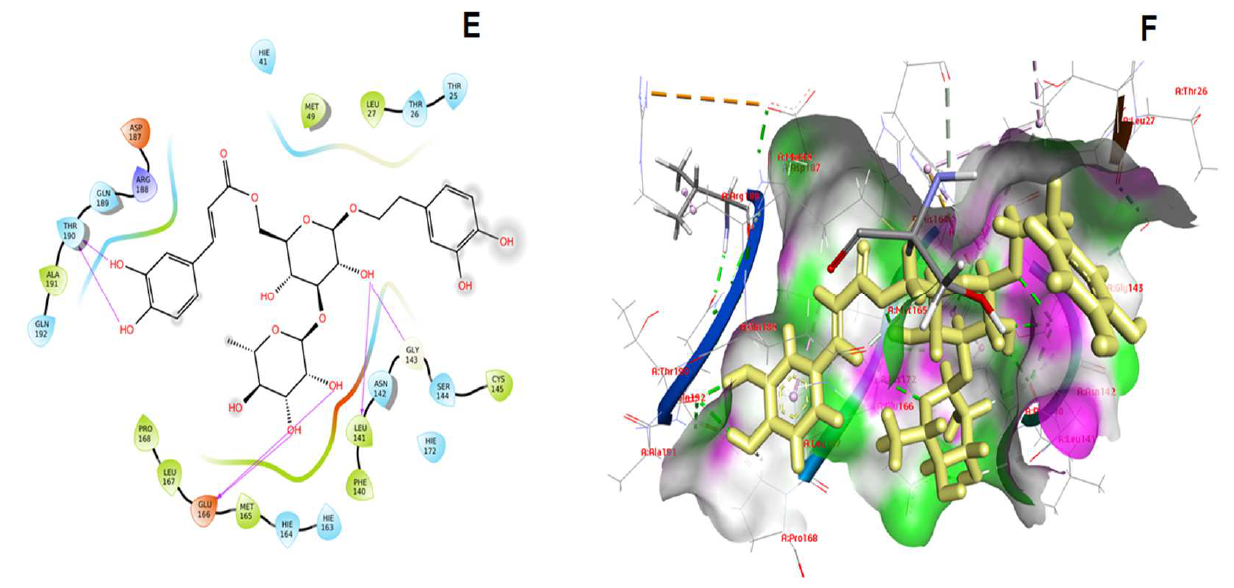
Figure 4. ( E , F ) Illustrations of the interaction between Isoacteoside and the target M pro protein of SARS-CoV-2.